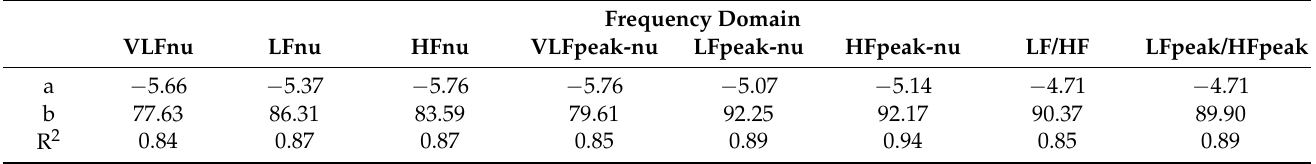
Table A3. Wilcoxon Rank Sum Test—Linear Regressions of the Statistical Percentages (subpart 3).